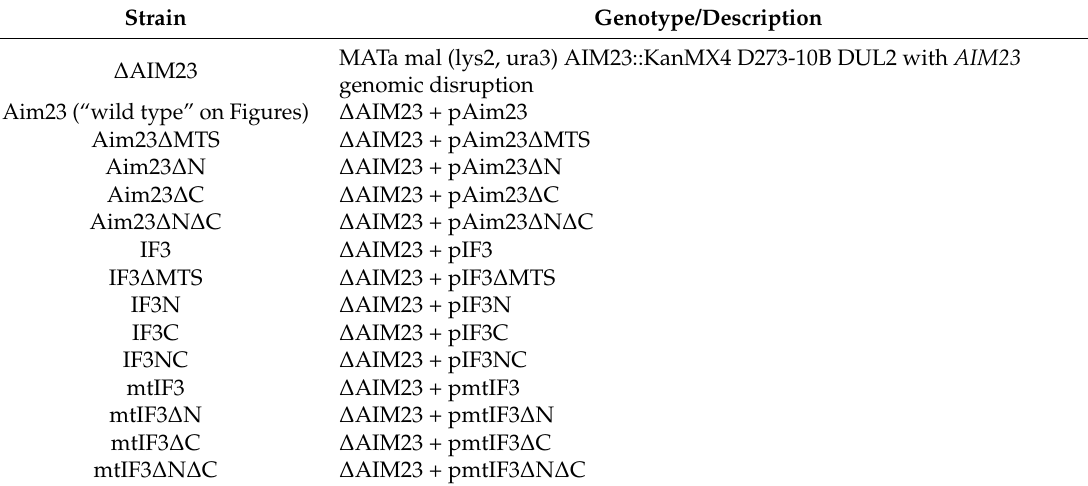
Table 2. S. cerevisiae strains used in the